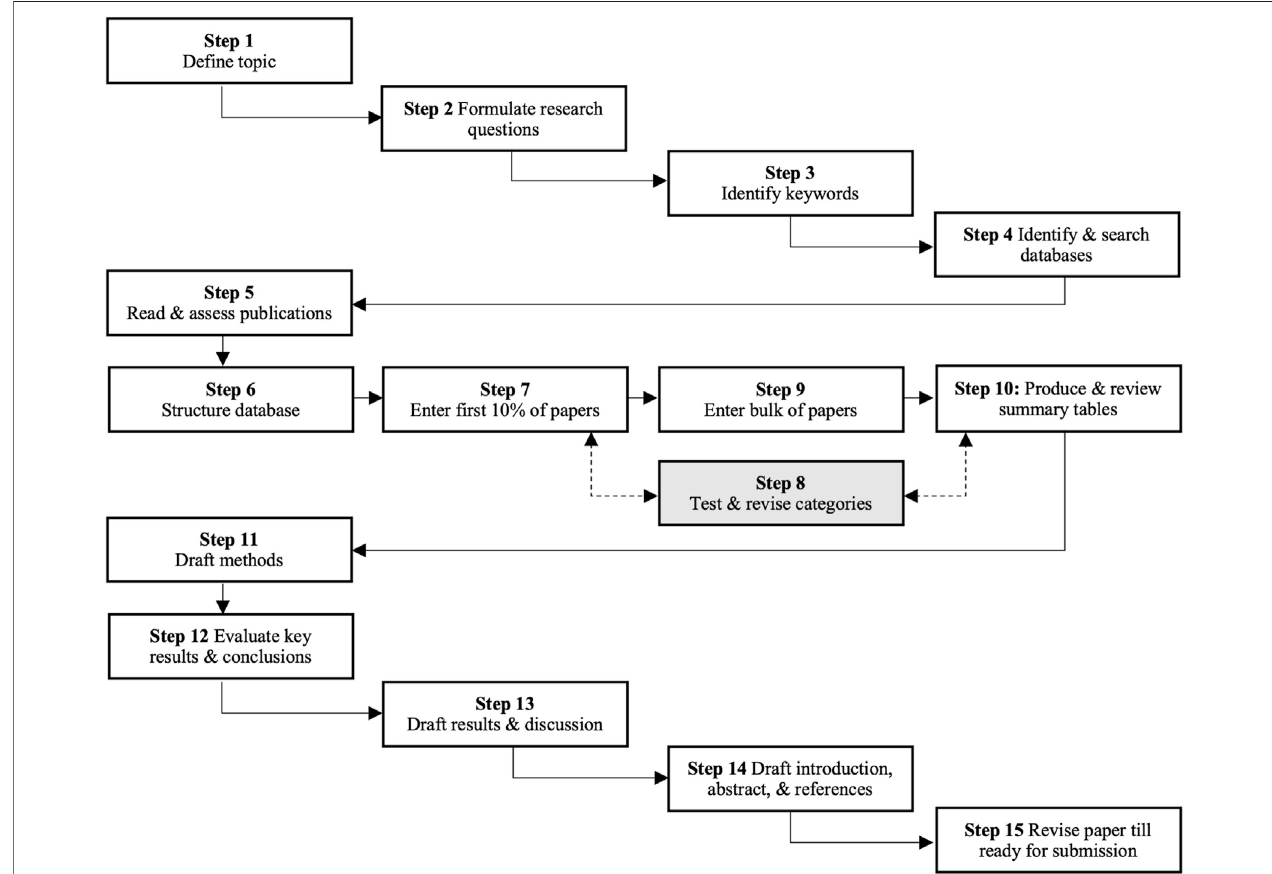
FIGURE 1 | The adopted systematic approach in this review